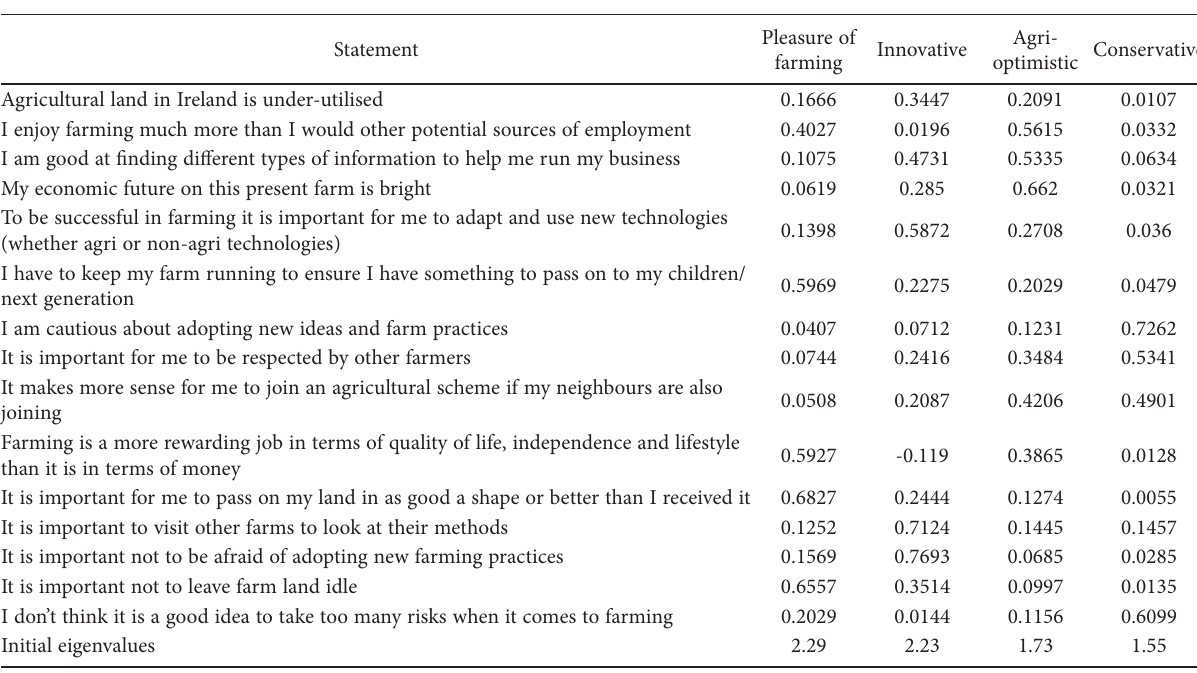
Table 3. Factor loadings of attitudinal